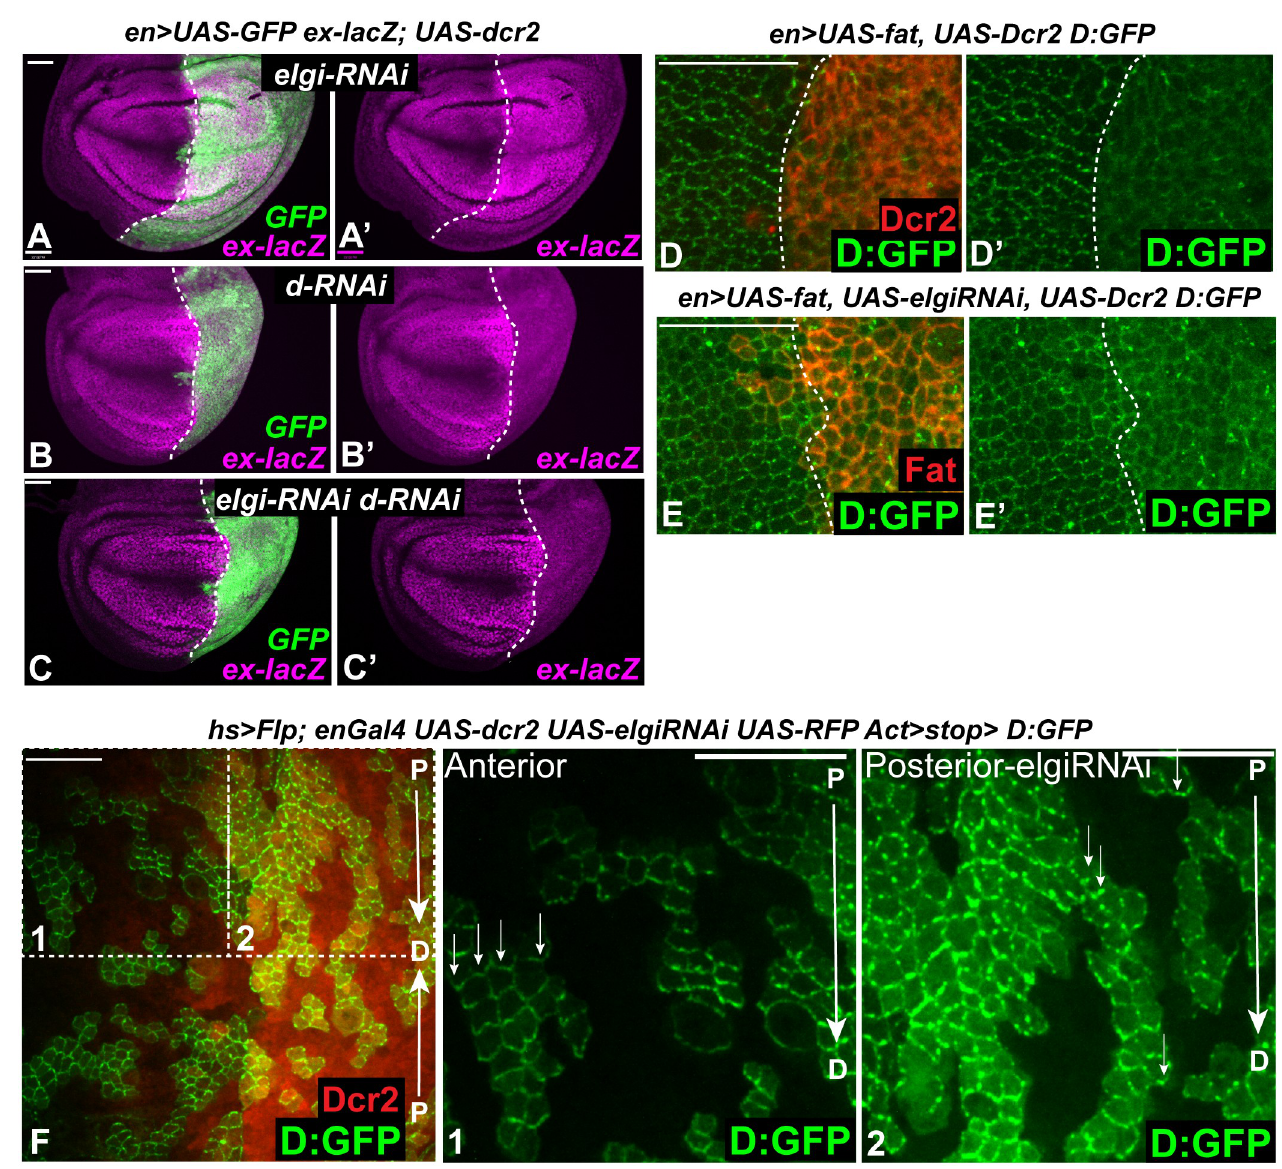
Fig 3. elgi regulates Dachs in parallel to Fat and does not affect Dachs polarity. (A-C) Third instar wing imaginal discs expressing en-Gal4 UAS-dcr2 UAS-GFP ex-lacZ and either UAS-elgi-RNAi (A, A’) or UAS-dachs-RNAi (UAS-d-RNAi) (B, B’) or UAS-elgi-RNAi and UAS-d-RNAi (C, C’), stained for expression of ex-lacZ (magenta), with posterior cells marked by expression of GFP (green). Dashed white line marks the A-P compartment boundary. Scale bar is 33 μ m. (D, E) Horizontal apical sections of wing imaginal discs expressing en-Gal4 UAS-dcr2 D : GFP UAS-Fat without (D, D’) or with (E, E’) UAS-elgi-RNAi showing displacement of membrane localized Dachs:GFP (D:GFP) into the cytoplasm. Posterior cells are marked by expression of Dcr2 or Fat (red) Dashed white line marks the A-P compartment boundary. Scale bar is 16.5 μ m. (F) Horizontal apical sections of wing imaginal discs expressing Dachs:GFP (D:GFP) in flipout clones and elgi-RNAi in the posterior compartment (marked by RFP, red). Arrows point in a proximal (P) to distal (D) direction. (1, 2) Magnified views of boxed areas in F with small arrows indicating preferential enrichment of D:GFP on the distal boundary of cells. Scale bar is 16.5 μ m.